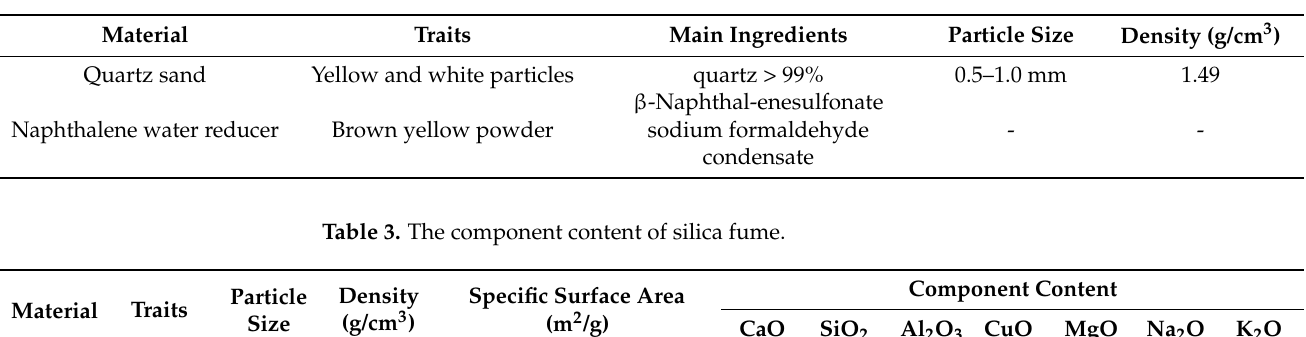
Table 2. Detailed parameters of rock-like material.